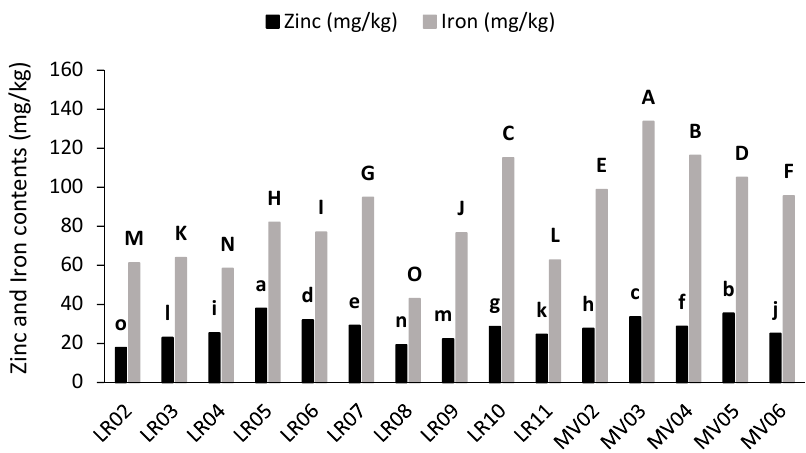
Figure 5. Zn and Fe contents of landraces and modern varieties. Upper-case letters compare the beans for Fe content (gray bars), and lower-case letters for Zn content (black bars). Means followed by the same upper- or lower-case letters are not significantly different (DMRT; P < 0.05).